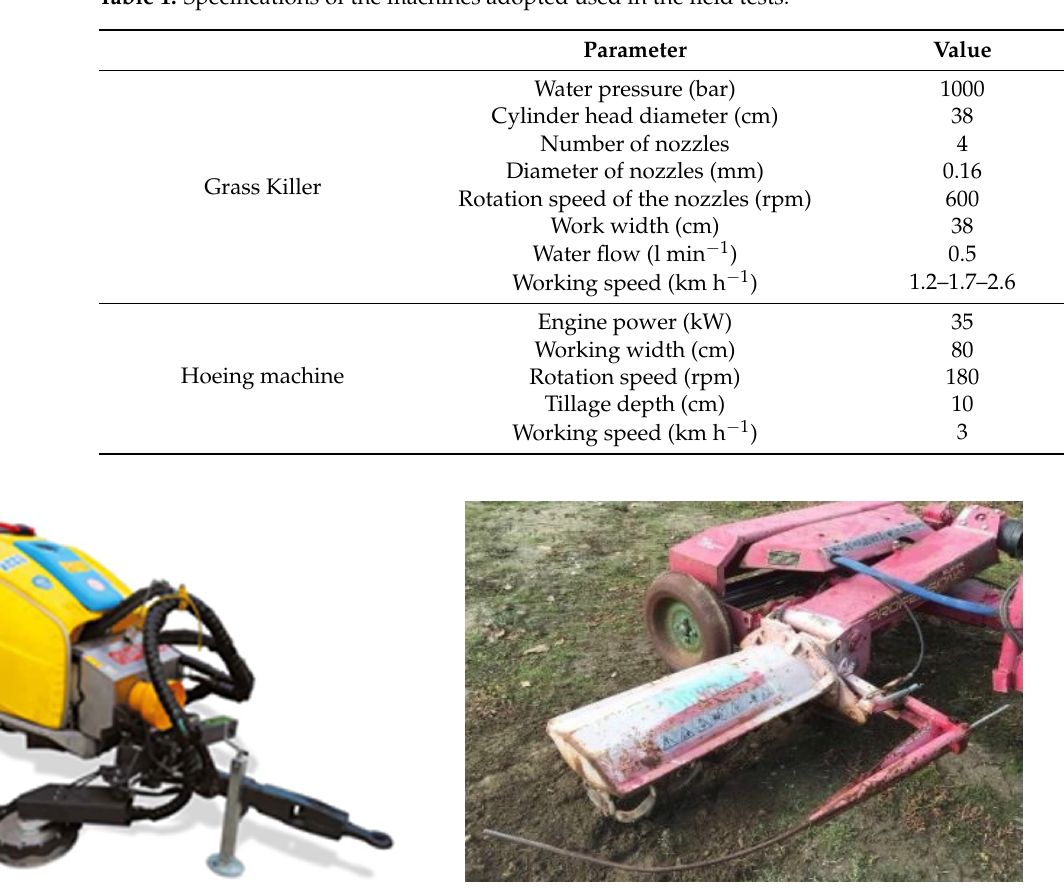
Table 1. Specifications of the machines adopted used in the field tests.